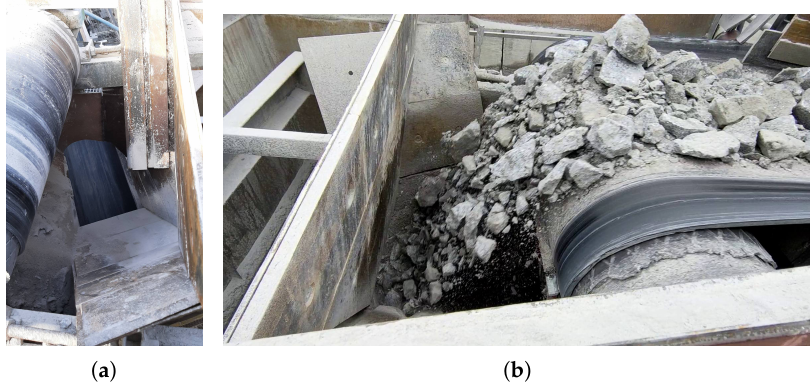
Figure 15. New transfer station: ( a ) prepared, and ( b ) in